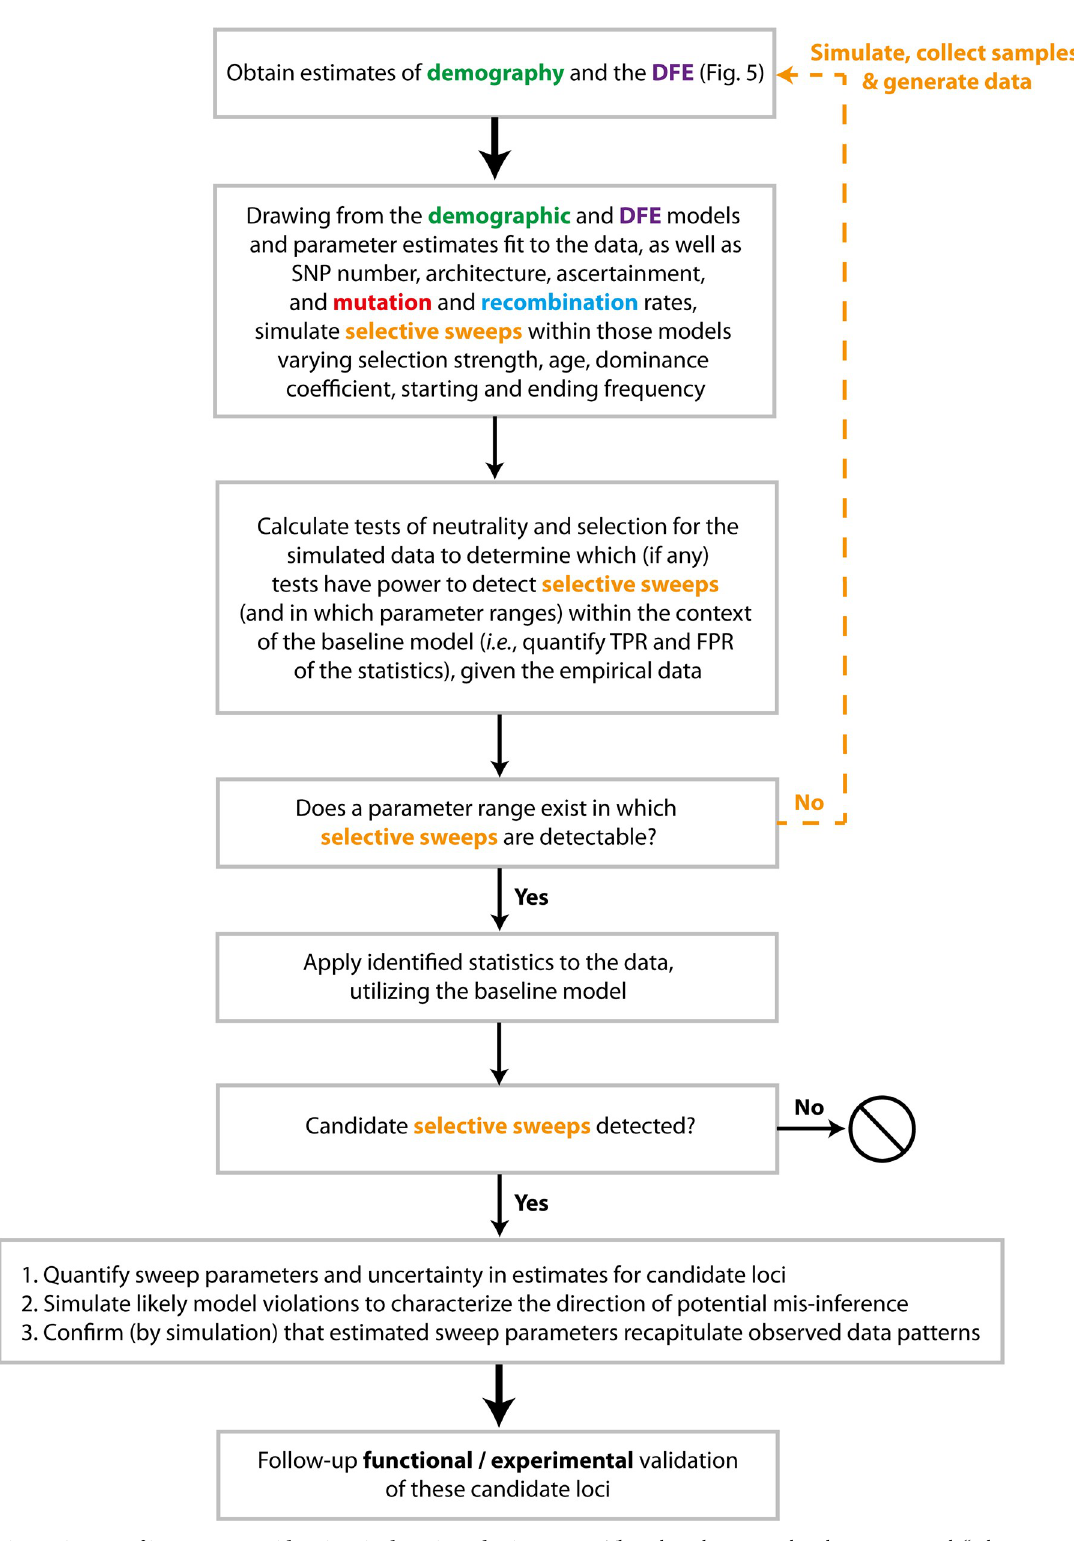
Fig 6. Diagram of important considerations in detecting selective sweeps. The color scheme matches that in Fig 5, with “selective sweeps” coded in orange. DFE, distribution of fitness effects; FPR, false positive rate; TPR, true positive rate.